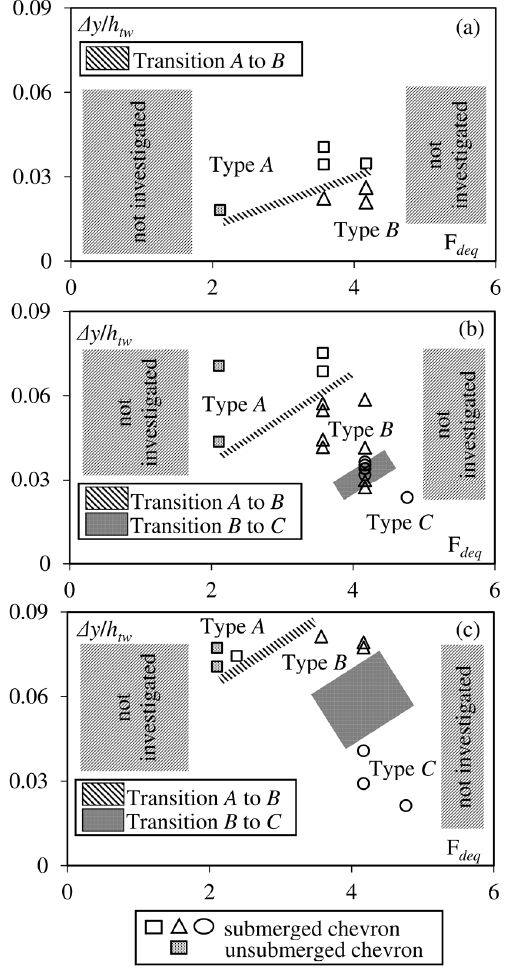
Figure 6. Existence fields of the various scour morphology types for chevron structure arrangement with ( a ) n = 1, ( b ) n = 2 and ( c ) n = 3.